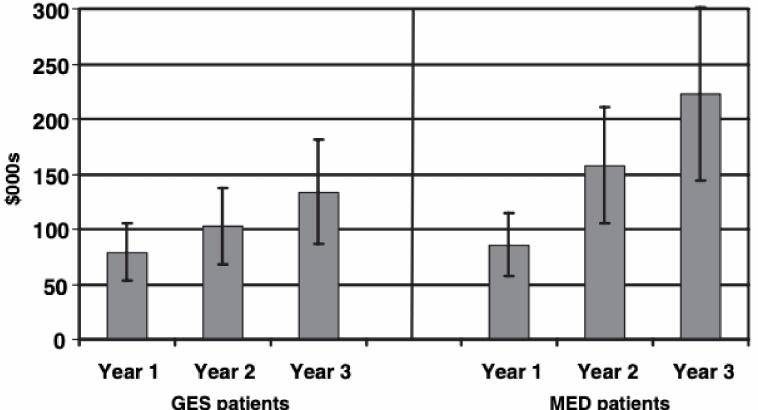
Figure 7. Decrease in health-related costs with GES vs. medical controls. Comparison of health-related costs of GES patients and patients treated with outpatient medical therapy in a long-term study. Cumulative costs for the first, second and third years after enrolment in the study